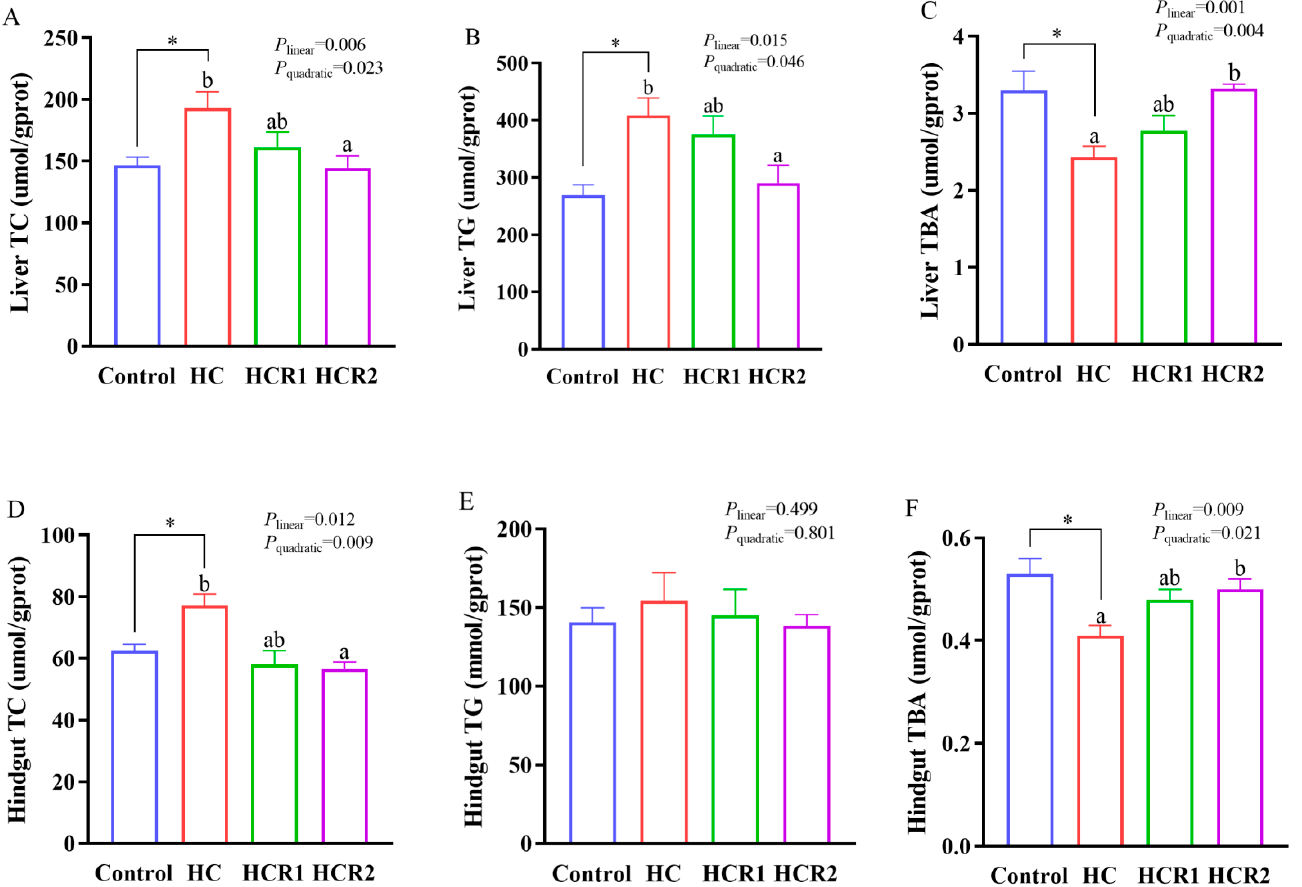
Figure 3. Liver TC ( A ), TG ( B ), and TBA ( C ) contents as well as hindgut TC ( D ), TG ( E ), and TBA ( F ) contents. Each data point represents the mean of four replicates (4 individuals per replicate). * Means p < 0.05, compared between the control and the HC group. ab Compared among the HC, HCR1, and HCR2 group. Bars assigned with different superscripts are significantly different ( p < 0.05). Control, diet with 32% nitrogen-free extract; HC, diet with 45% nitrogen-free extract; HCR1, diet with 45% nitrogen-free extract and 0.04% resveratrol; HCR2, diet with 45% nitrogen-free ex- tract and 0.08% resveratrol. TC, total cholesterol; TG, total triglycerides; TBA, total bile acid.